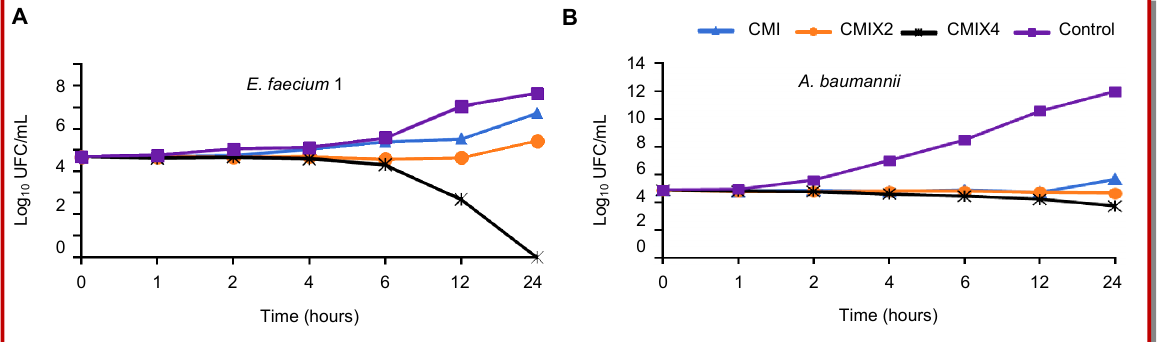
Figure 5: Time kill curve of ethyl acetate crude extract of PLR9 aga inst E. faecium 1 (A) and A. baumannii (B) at MIC, 2x MIC and 4x